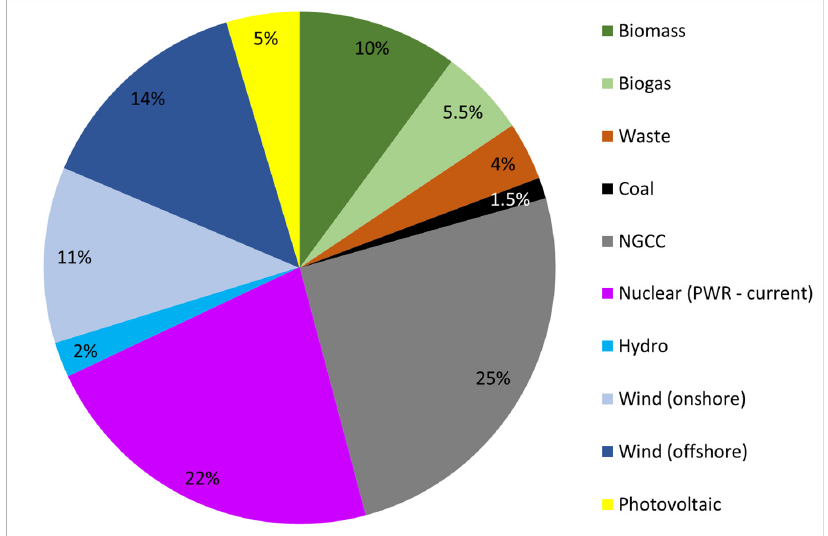
Figure 1. Current (2019) UK grid mix composition, in terms of total electricity generated. NGCC = natural gas combined cycles; PWR = pressure water reactors.